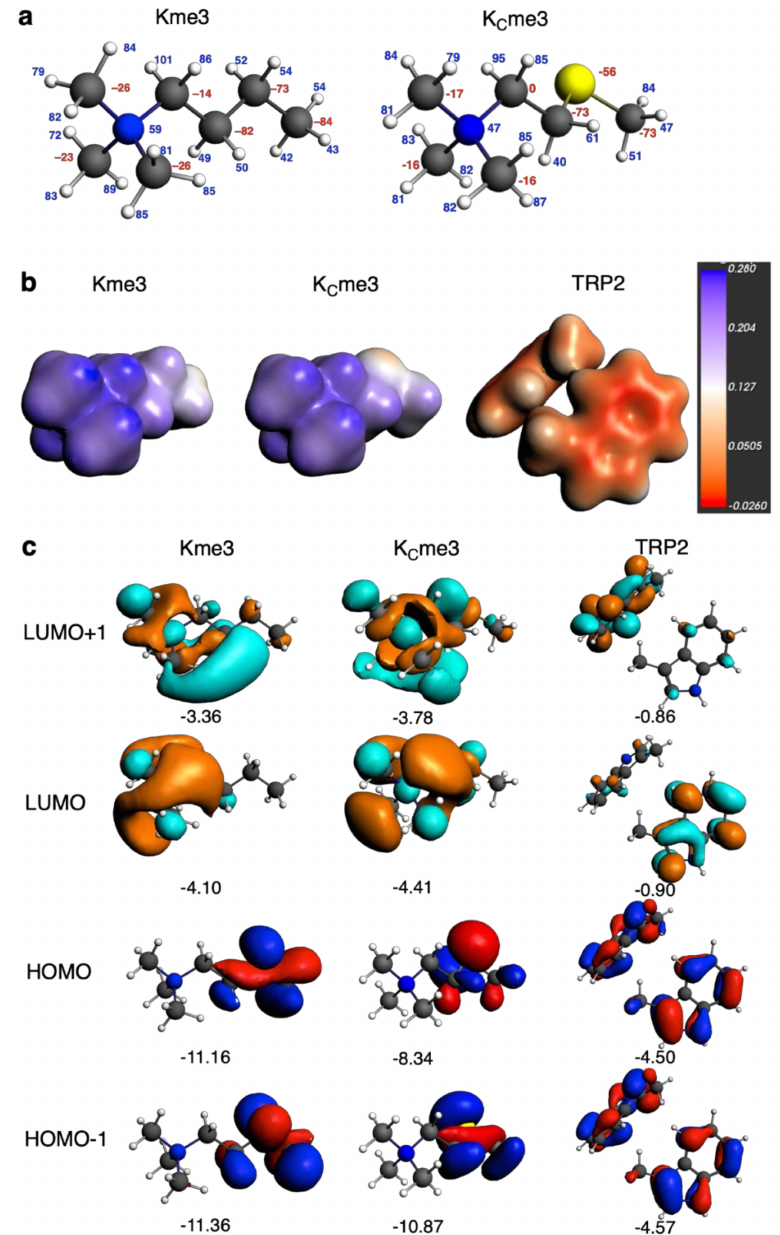
Figure 4. Computational analysis of Kme3, K C me3 and TRP2, computed at BLYP-D3BJ / TZ2P using frozen on X-ray structures for TRP2 and positions of C α and full geometrical relaxation for all other portions: ( a ) Voronoi Deformation Density (VDD) atomic charges (in milli-a.u.; red = negative, blue = positive); ( b ) molecular electrostatic potential isosurfaces for Kme3, K C me3 and TRP2 (in a.u.); ( c ) frontier orbitals (isosurafce at 0.03) and orbital energies (in